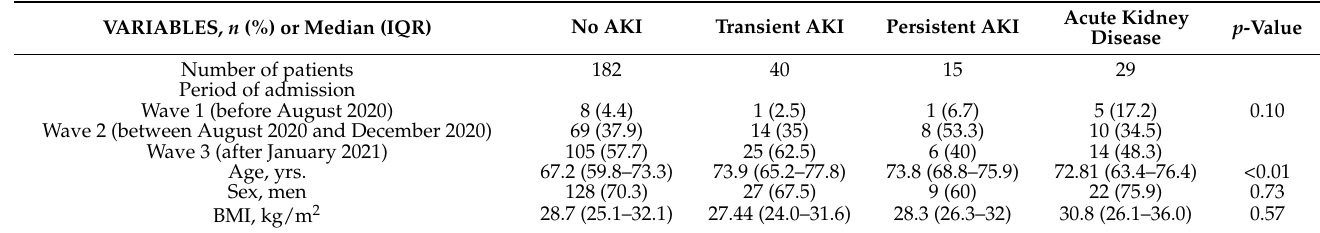
Table 3. Characteristics of the critically ill COVID-19 patients according to renal